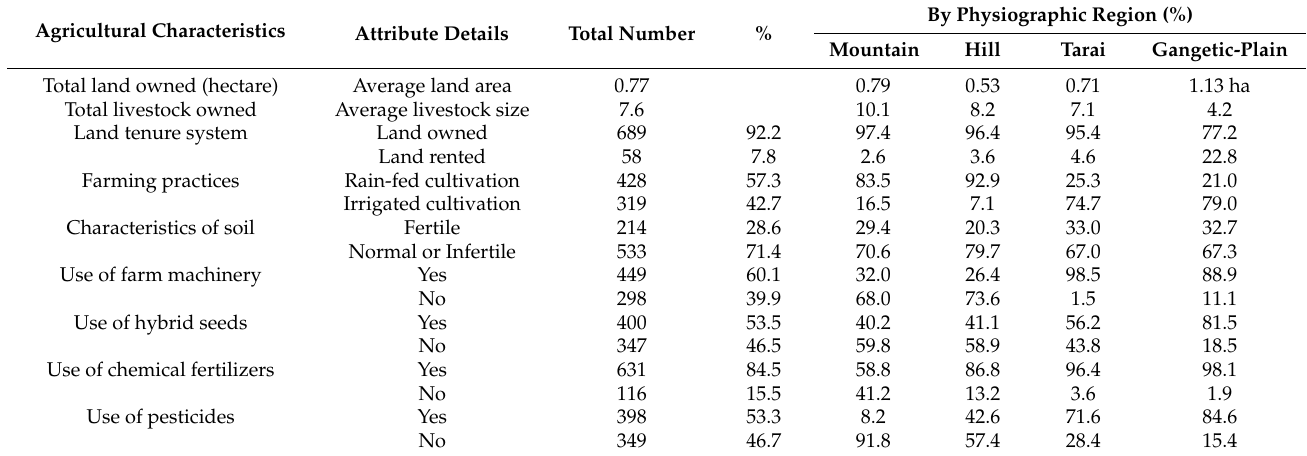
Table 5. Agricultural characteristics for the surveyed farmers in the trans-boundary KRB. Agricultural